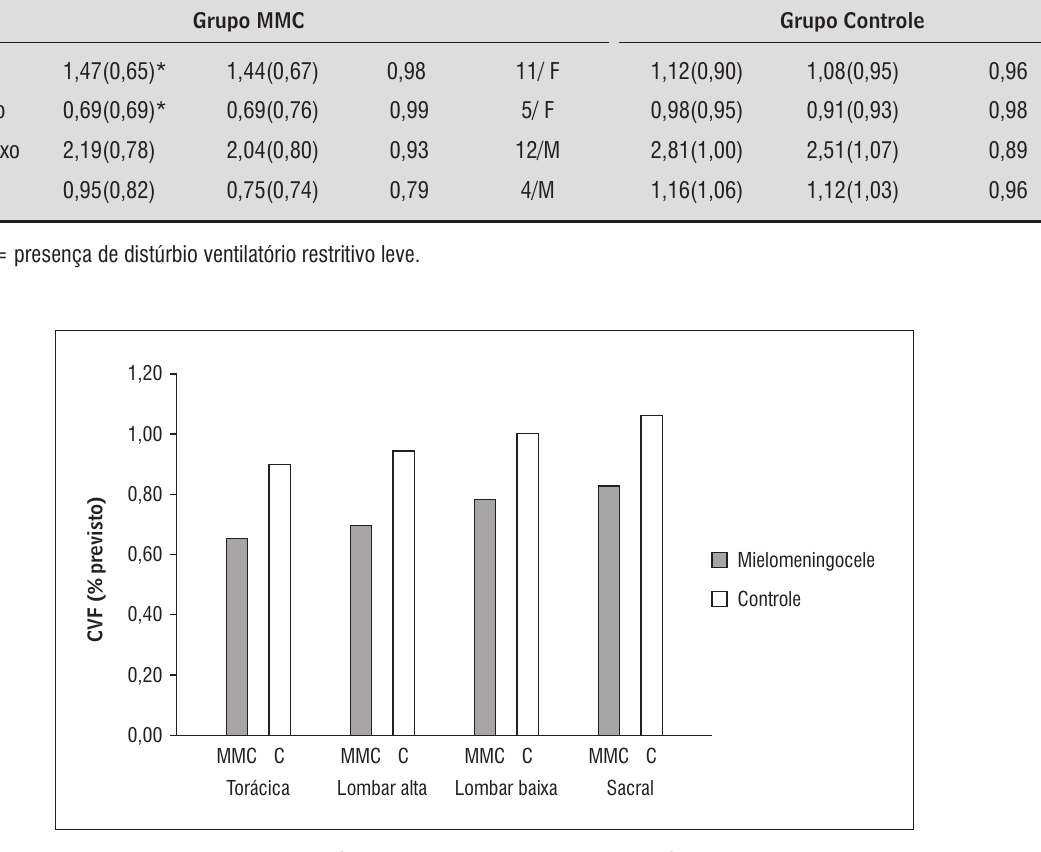
Figura 1 - Representação gráfica dos valores de capacidade vital forçada dos casos de MMC com diferentes níveis de lesões e seus respectivos controles